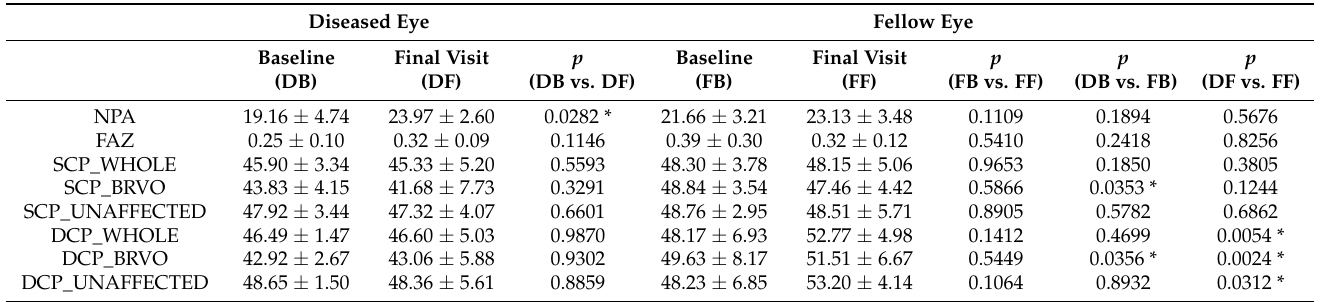
Table 2. NPA, FAZ, SCP, DCP changes in Diseased Eye and Fellow Eye.